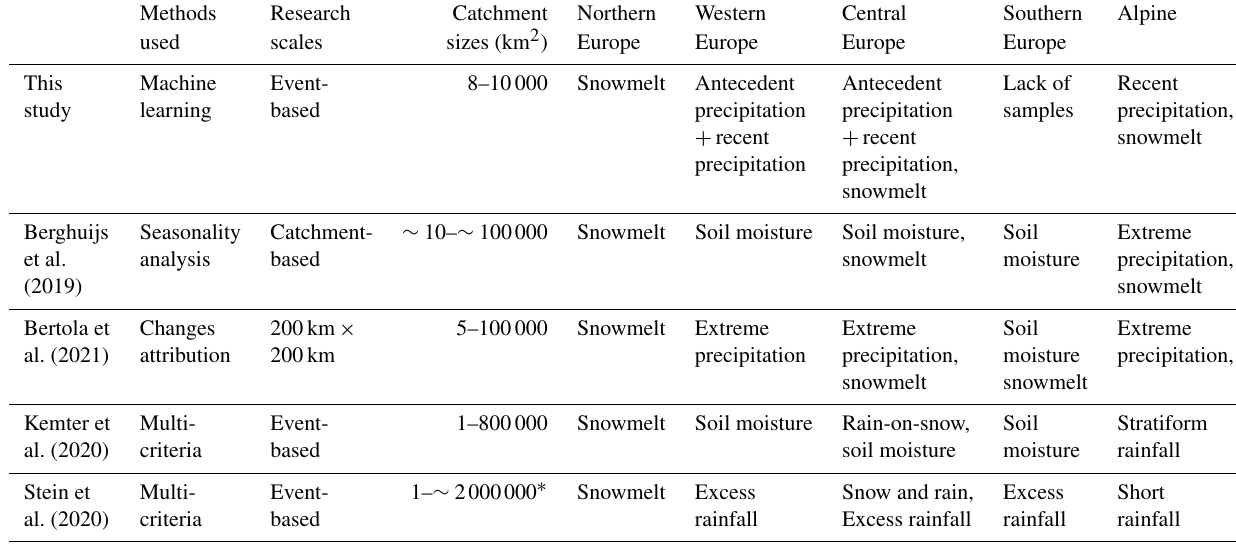
Table 1. Comparisons of flooding mechanisms in Europe identified by different methods.